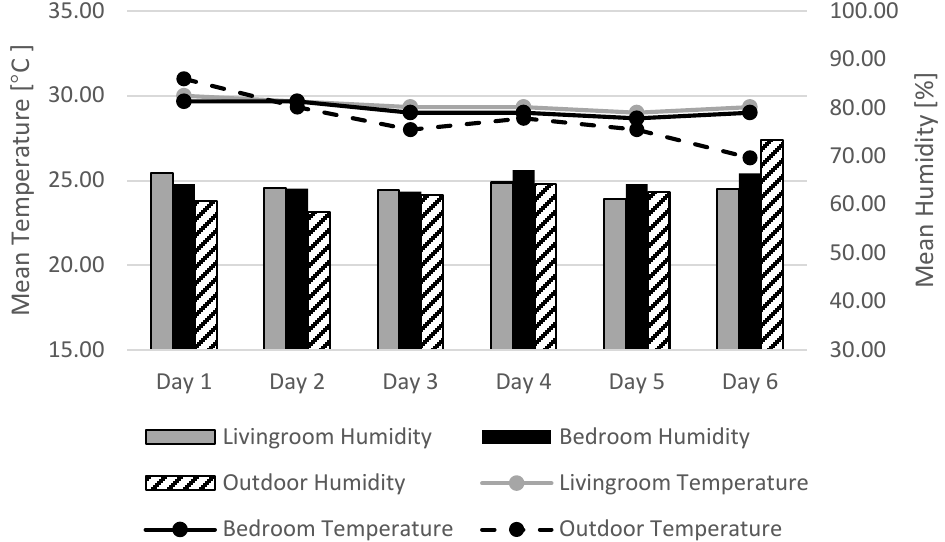
Figure 6. Indoor/outdoor temperatures and humidity averaged from 07:00 – 10:00, 12:00 – 15:00, and 17:00 – 21:00 (HRB1).